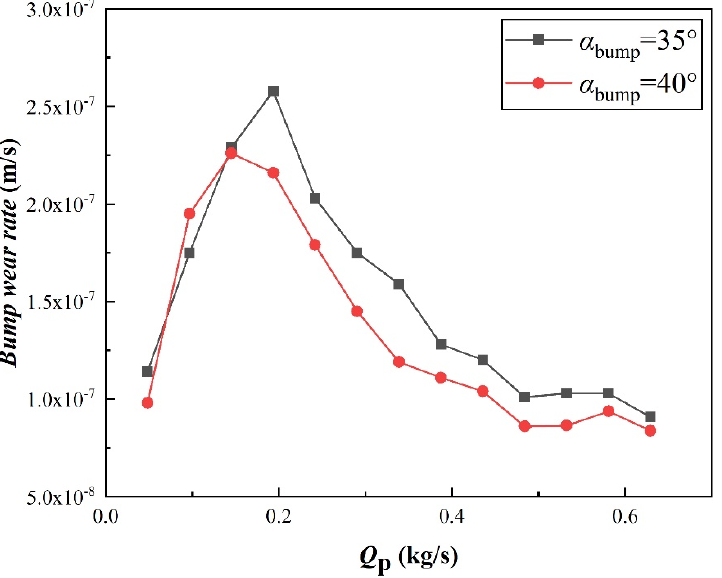
Figure 14. The variation of the maximum wear rate of the bump with the particle mass flow rate.